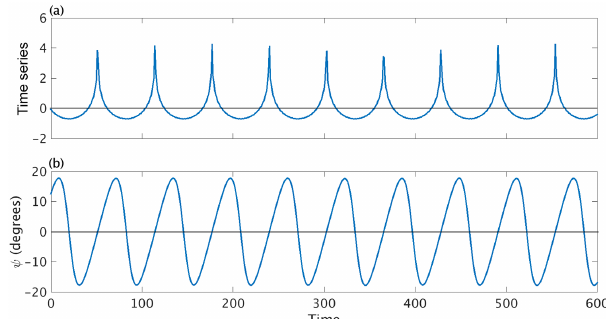
Figure 2. (a) a skewed time series and (b) its corresponding local biphase. The biphase close to zero indicates a nonlinear interaction resulting in a skewed oscillation. The biphase was calculated from the first three cosines in the summation described in the text.